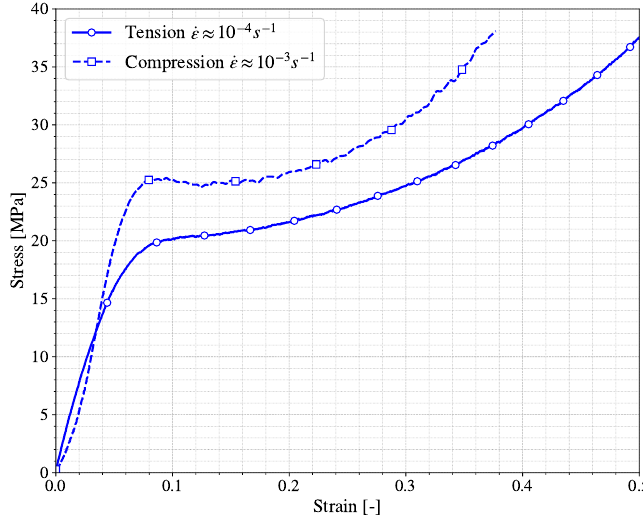
Figure 6. True stress vs. true strain of tensile and compression tests.